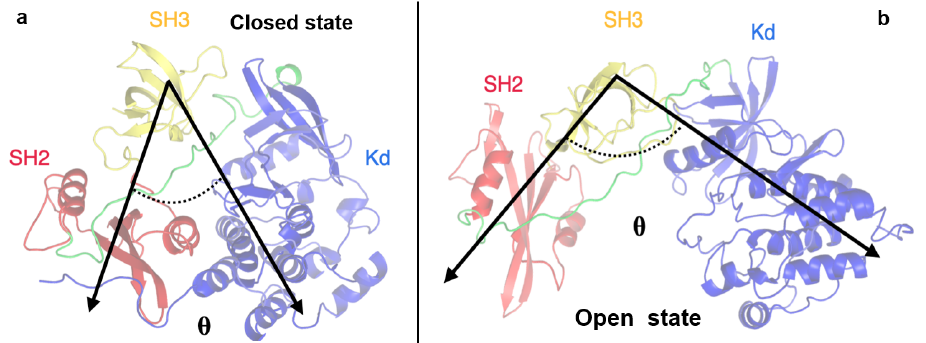
Figure 6. Representation of the angle θ K 23 defined by the SH2-SH3-KD domains. The θ K 23 angle describing the closed (panel a ) and open states (panel b ) is indicated by black arrows. The domains are labelled.